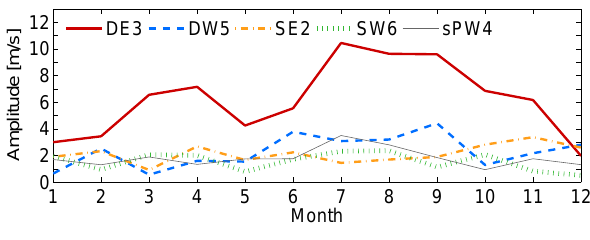
Fig. 3. Amplitude of the diurnal (DE3, DW5), semidiurnal (SE2, SW6) and stationary (sPW4) components contributing to the ob- served wave-4 structure in the zonal wind along the dip equator versus month of the year. DE3 is the most prominent component throughout the year and thus responsible for the observed wave-4